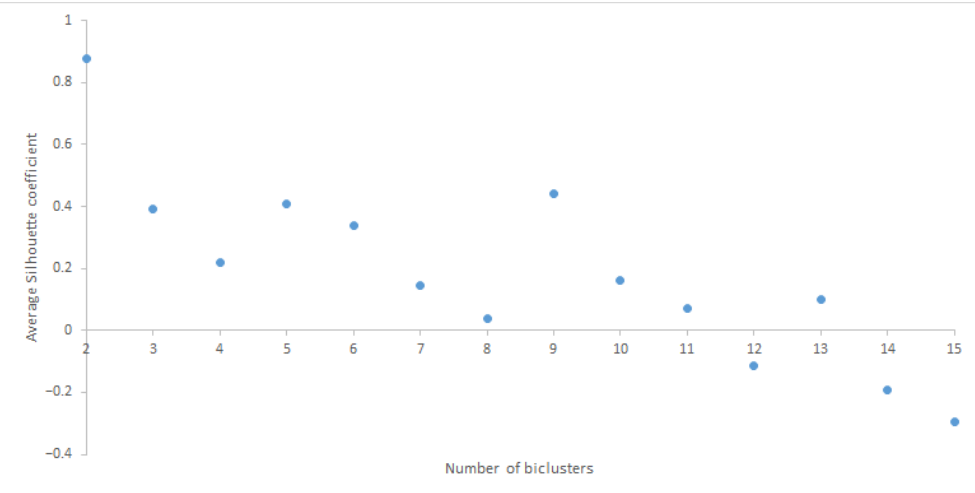
Figure 1. Average Silhouette coefficient given the number of biclusters,